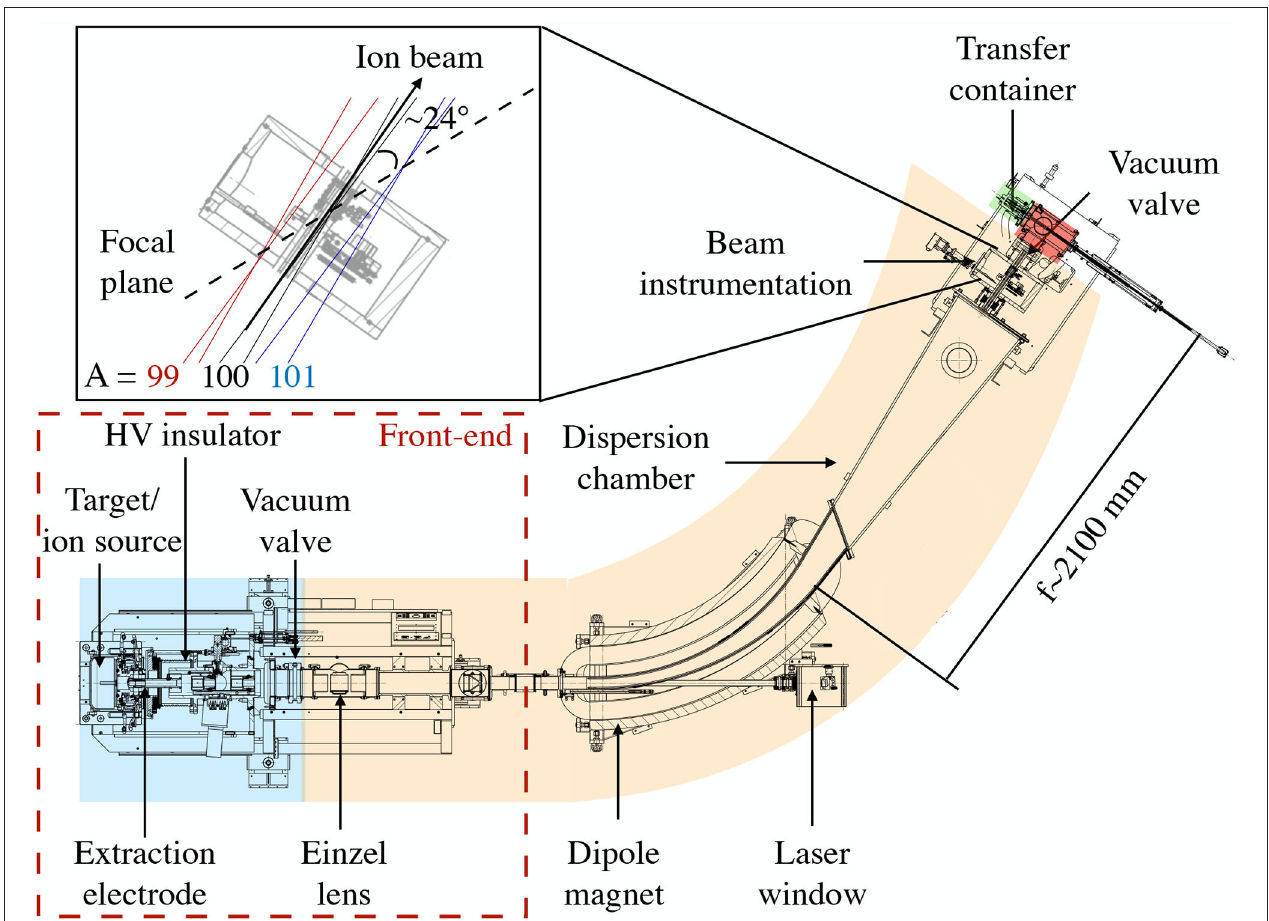
FIGURE 1 | CERN-MEDICIS beamline with the main elements highlighted. The inset shows the inclination of the focal plane with respect to the ion beam in the central trajectory (A/q = 100). This plane is determined by the focal distance of ion beams with mass A/q = 99, 100, and 101. The different pumping sectors—target, separator, collection box, and transfer container—are shown in blue, orange, red, and green,